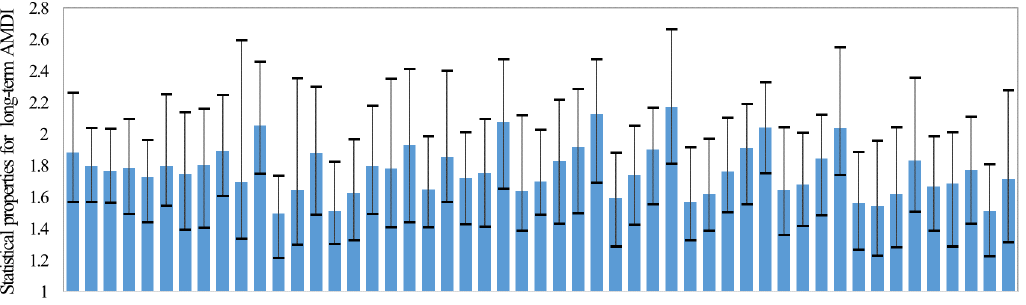
Figure 8. The mean and extreme of the long-term AMDI (annual marginal disorder index) of daily precipitation during 1979–2015 at selected grid.